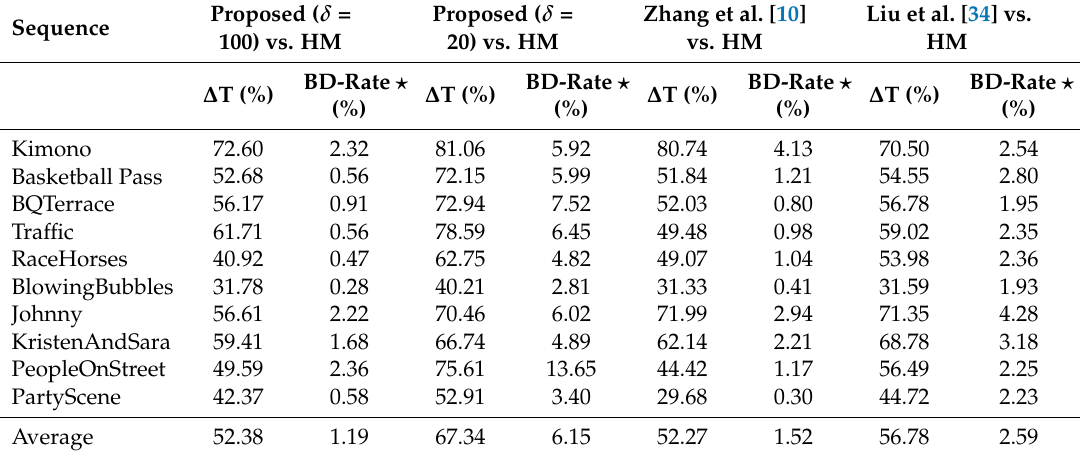
Table 3. Coding efficiency and complexity reduction performance (All Intra main).